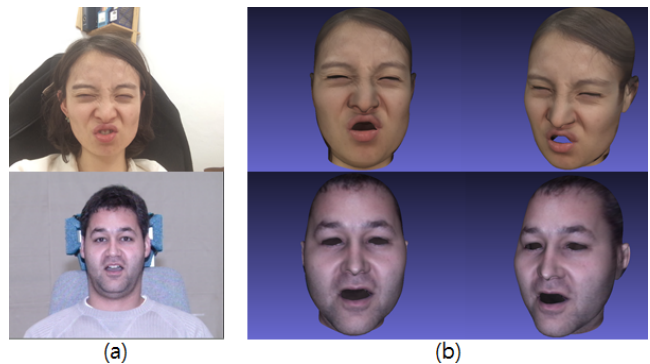
Figure 3. Resulting 3D faces: ( a ) Input images. ( b ) 3D faces.